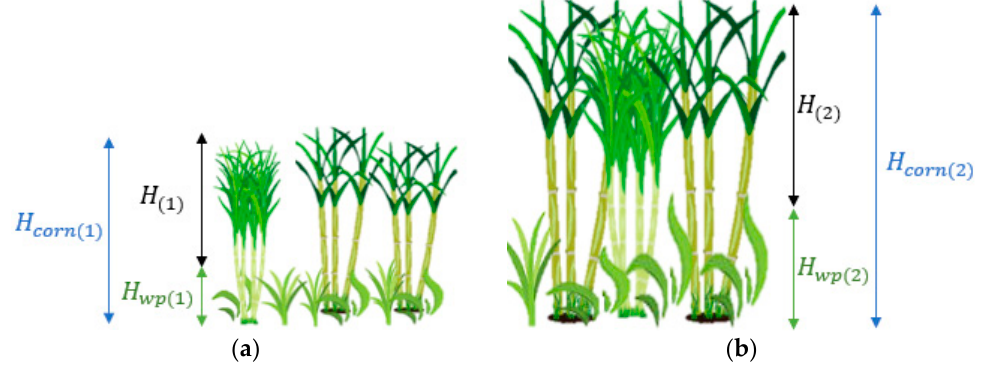
Figure 7. Crop in two different stages. ( a ) Day 1. ( b ) Day 2.